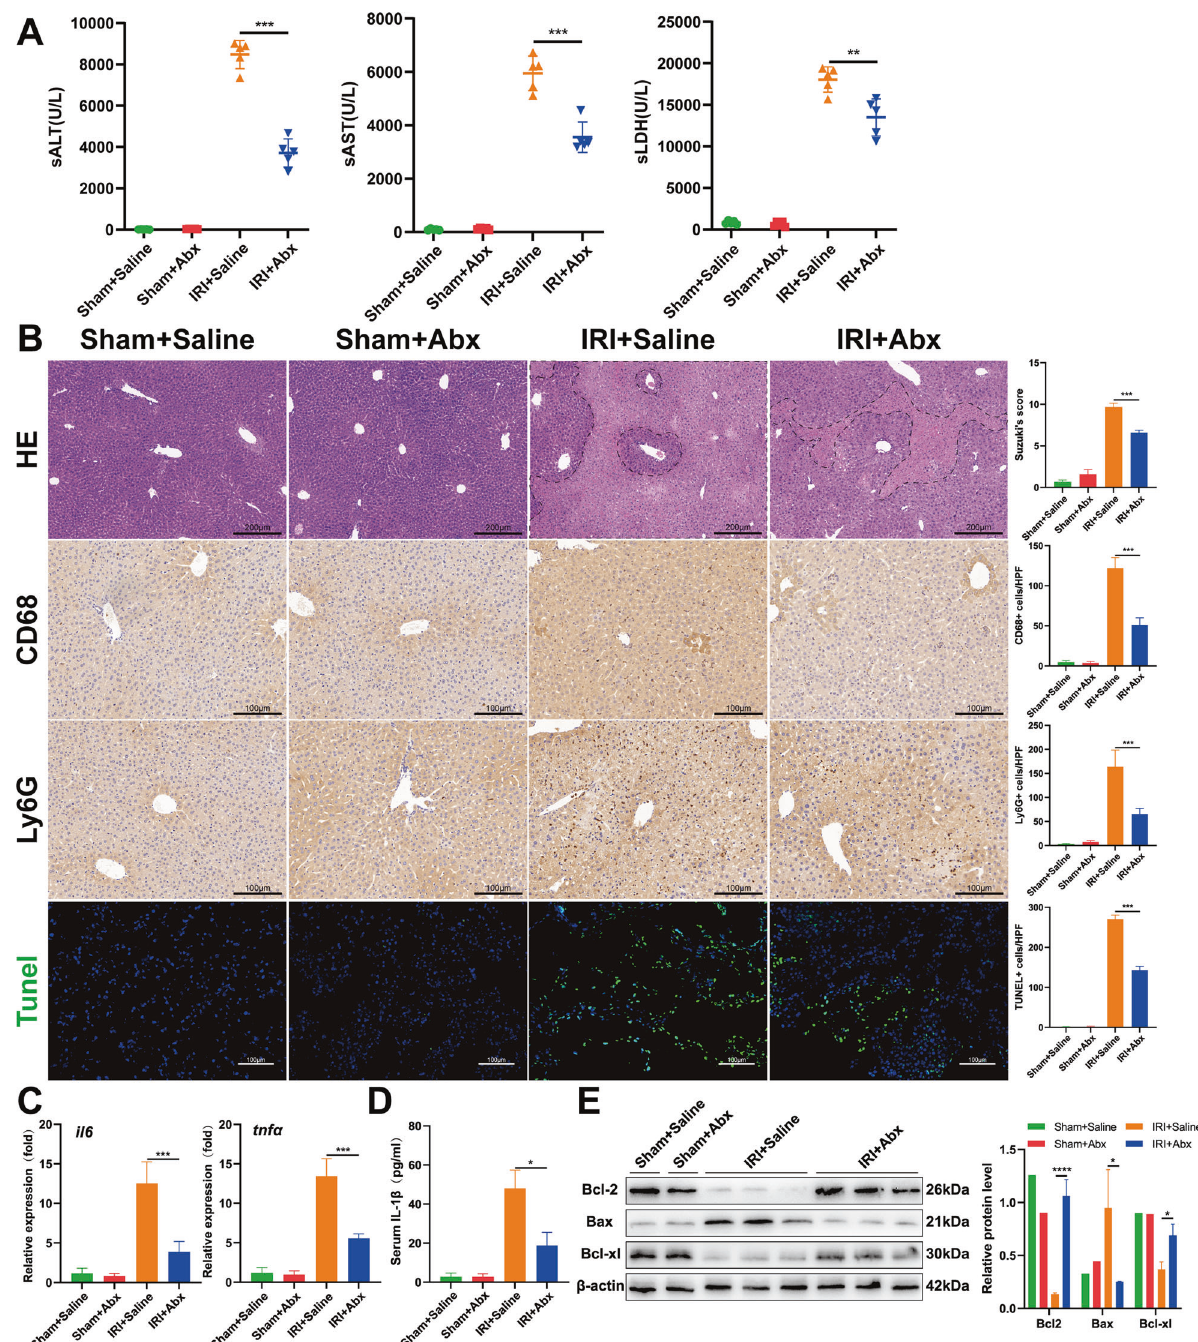
Fig. 1 Abx pretreatment protects the liver from IRI. A The levels of serum ALT, AST, and LDH in saline- and Abx-treated mice were determined after 90 min of ischemia and 6 h of reperfusion. B Representative H&E, CD68, Ly6G, and TUNEL staining of liver sections after IRI. Scale bars, 200, 100, 100, 100 μ m. C The expression of IL-6 and TNF- α at the mRNA level in different groups after IRI. ( n = 5 per group) ( D ) Serum IL-1 β levels in different groups after IRI. E The expression levels of Bcl-2, Bax, and Bcl-xl at the protein level in each group. Data are the mean ± SEM, ∗ p < 0.05; ∗∗ p < 0.01; ∗∗∗ p < 0.001 by unpaired Student ’ s t (IMs) (CD11b + Ly6C + ) was signi fi cantly decreased in the Abx- pathogenesis of IRI [2, 27, 28]. To investigate whether Abx treated group (Fig. 2A). IMs were further categorized into two pretreatment had an impact on the composition of innate subgroups based on the expression of Ly6C (Ly6C hi and Ly6C lo ). immune cells and thus affected liver IRI outcomes, fl ow cytometry was used to characterize the hepatic cell population. After IRI Figure 2C shows that the reduction in IMs after Abx pretreatment modeling, the proportions of CD3 + T cells, CD4 + T cells, CD8 + was mainly attributed to the decrease in the Ly6C hi subset, which T cells, NK cells, and NKT cells were not different between the two groups, while the proportion of hepatic in fi ltrating macrophages